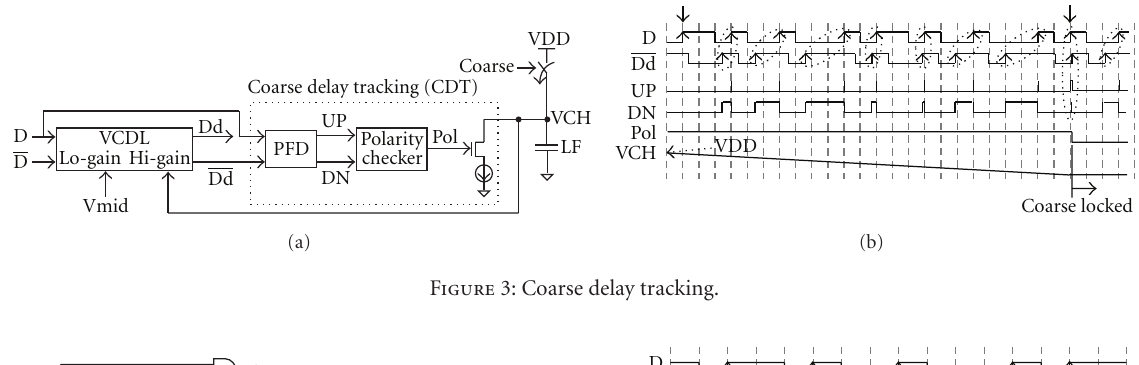
Figure 3: Coarse delay tracking.